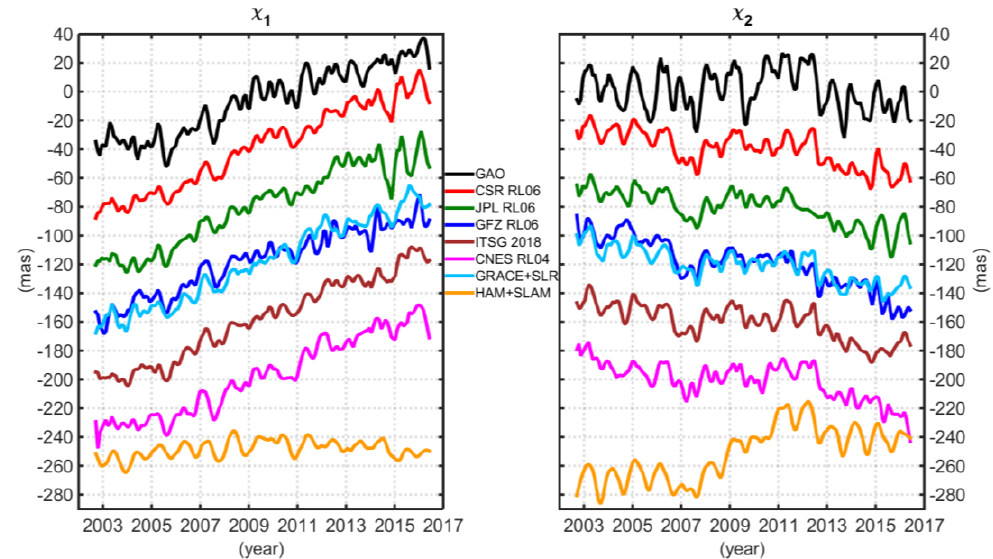
Figure 2. χ 1 and χ 2 components of GAO, GSMAM, GRACE + SLR and HAM + SLAM obtained from geophysical models processed at GFZ. Each time series was filtered using Gaussian filter with FWHM (full width at half maximum) equal to 60 days. The same time period was considered for all data sets, namely between September 2002 and June 2016. Table 1. Standard deviation of time series, correlation coefficients with GAO, and percentage of variance in GAO explained by GSMAM, GRACE + SLR and HAM + SLAM. Before computing the values, linear trends were removed from the series. Note that the critical value of the correlation coefficient for 54 independent points and the confidence level of 0.95 was 0.23. The standard error of the difference between two correlation coefficients for 54 independent points was 0.20. The highest values of correlations and relative explained variances are italicized. Standard Deviation of Time Correlation Coe ffi cient Relative Explained Series (mas) with GAO Variance Series